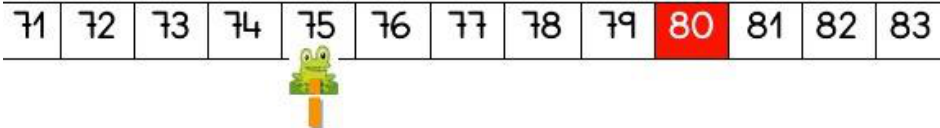
Figure 28. Saltarina is on 75.